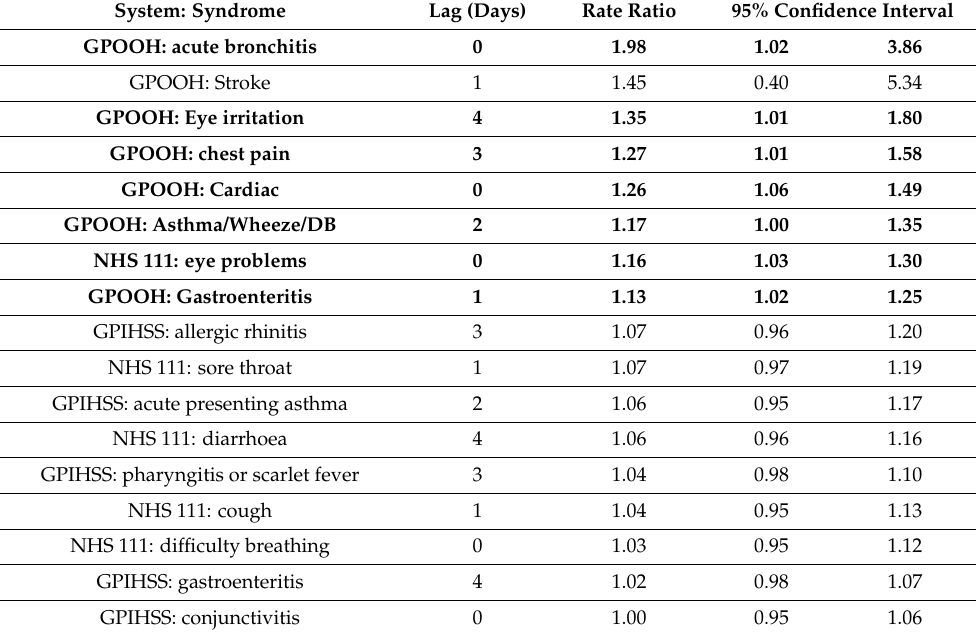
Table 2. Meta analysis results—estimate of rate ratios for direct effect of air pollution on syndromic indicators. Results where lower 95% confidence interval is at least 1 are highlighted in